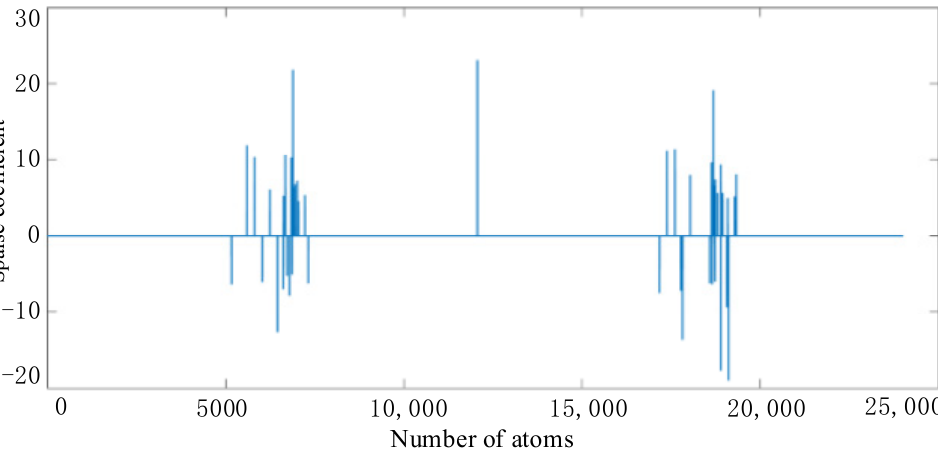
Figure 18. Time-domain waveform of the harmonic components extracted by the adapOMP. 0